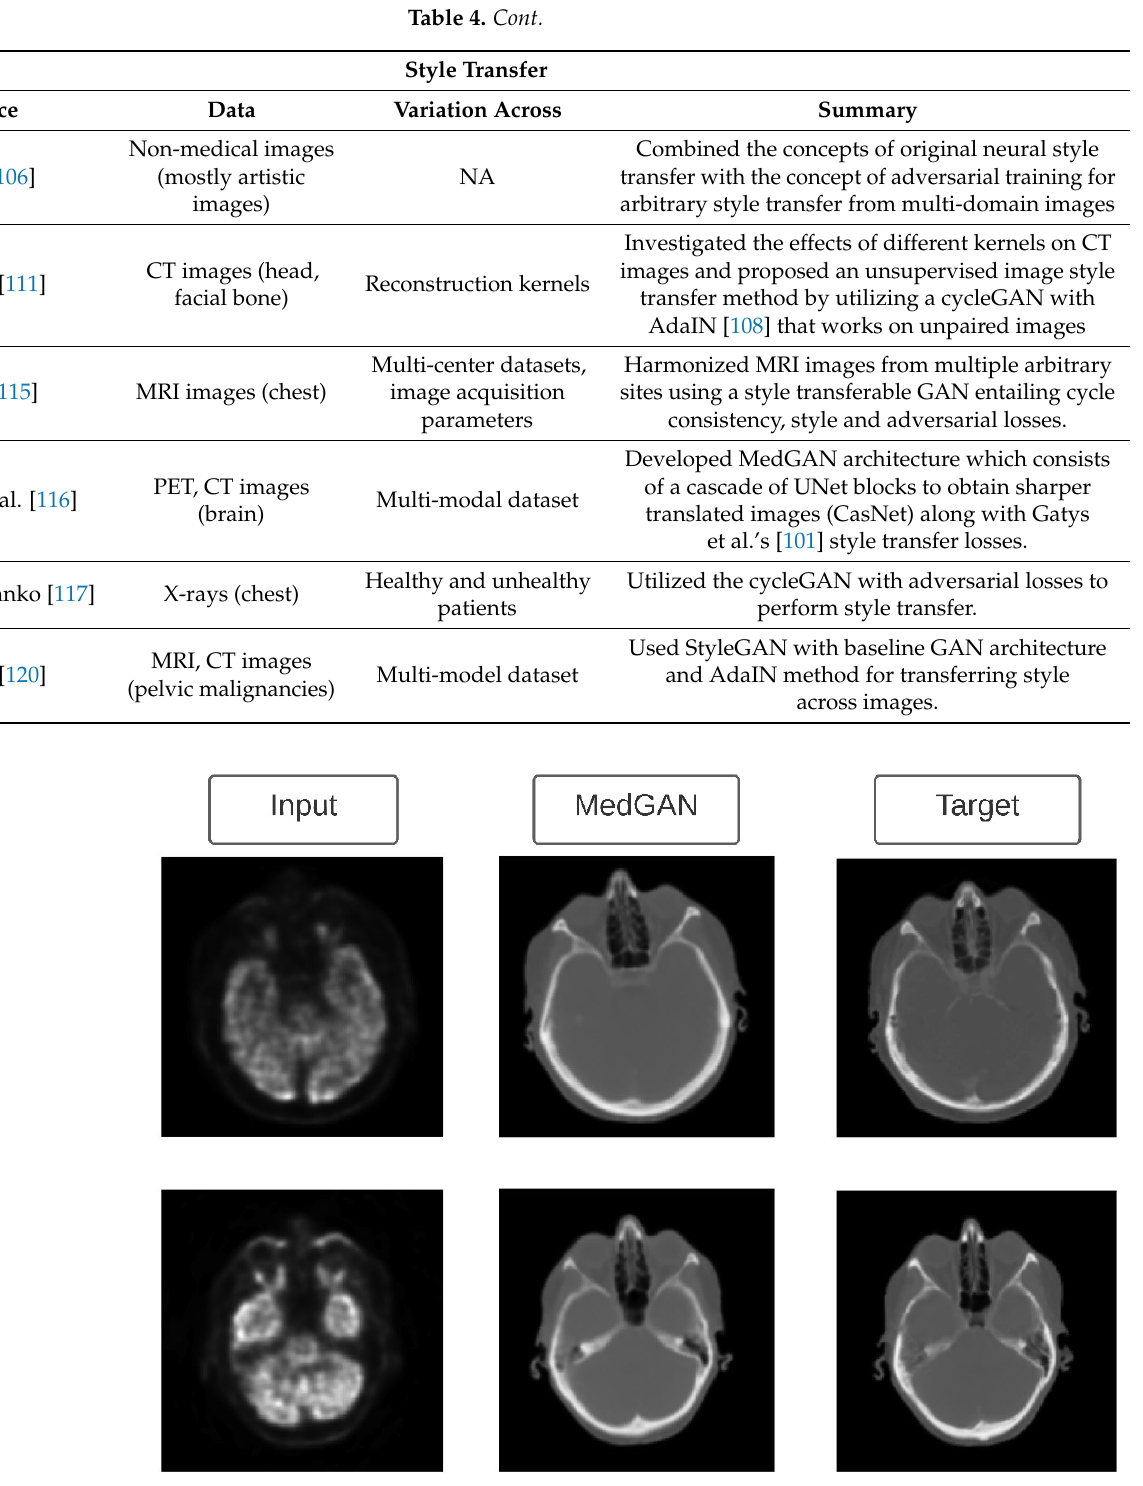
Figure 6. PET to CT translation using MedGAN. Figure adapted from [116] with permission from Elsevier.